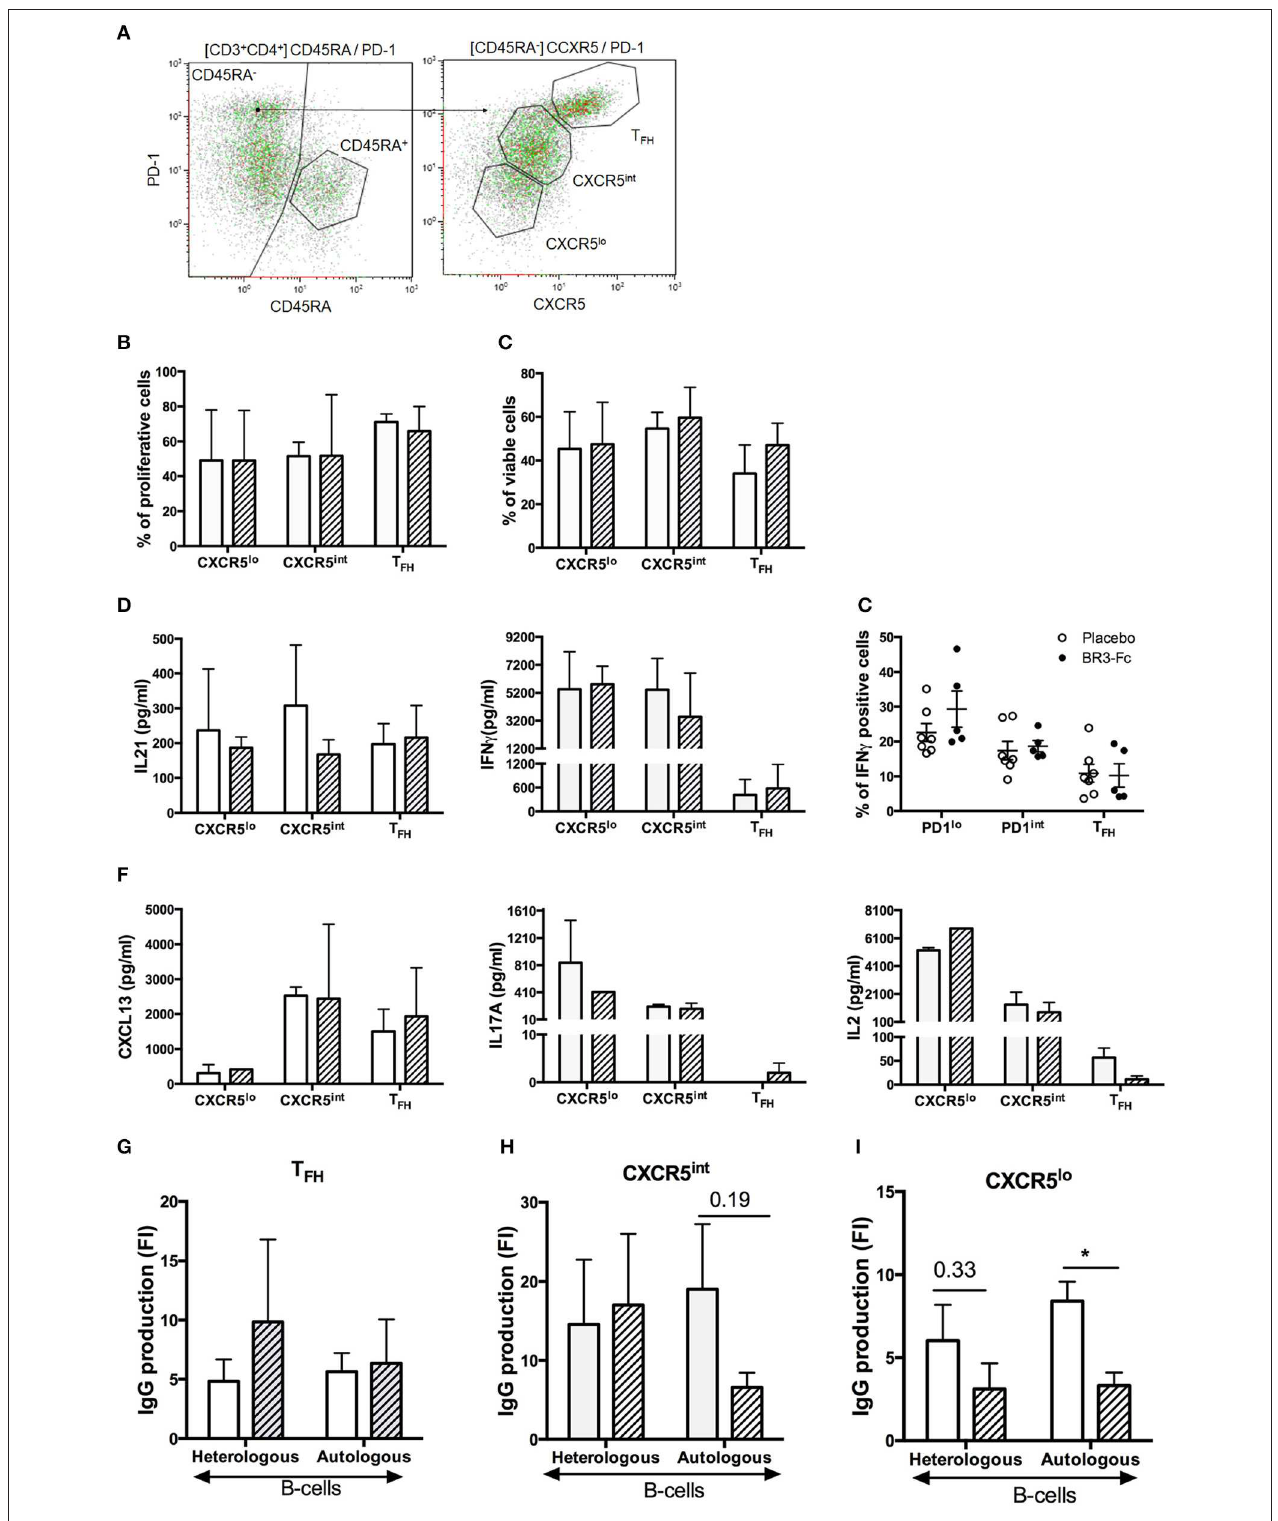
FIGURE 8 | Sorting strategy and Functional responses of T FH from Placebo and BR3-Fc treated macaques. (A) After gating on live CD3 + CD4 + CD45RA − T-cells, mCD4 T-cells were sorted according to the intensity of PD1 and CXCR5 expression into three populations: T FH (PD1 hi CXCR5 hi ), CXCR5 int (PD1 int CXCR5 int ), and